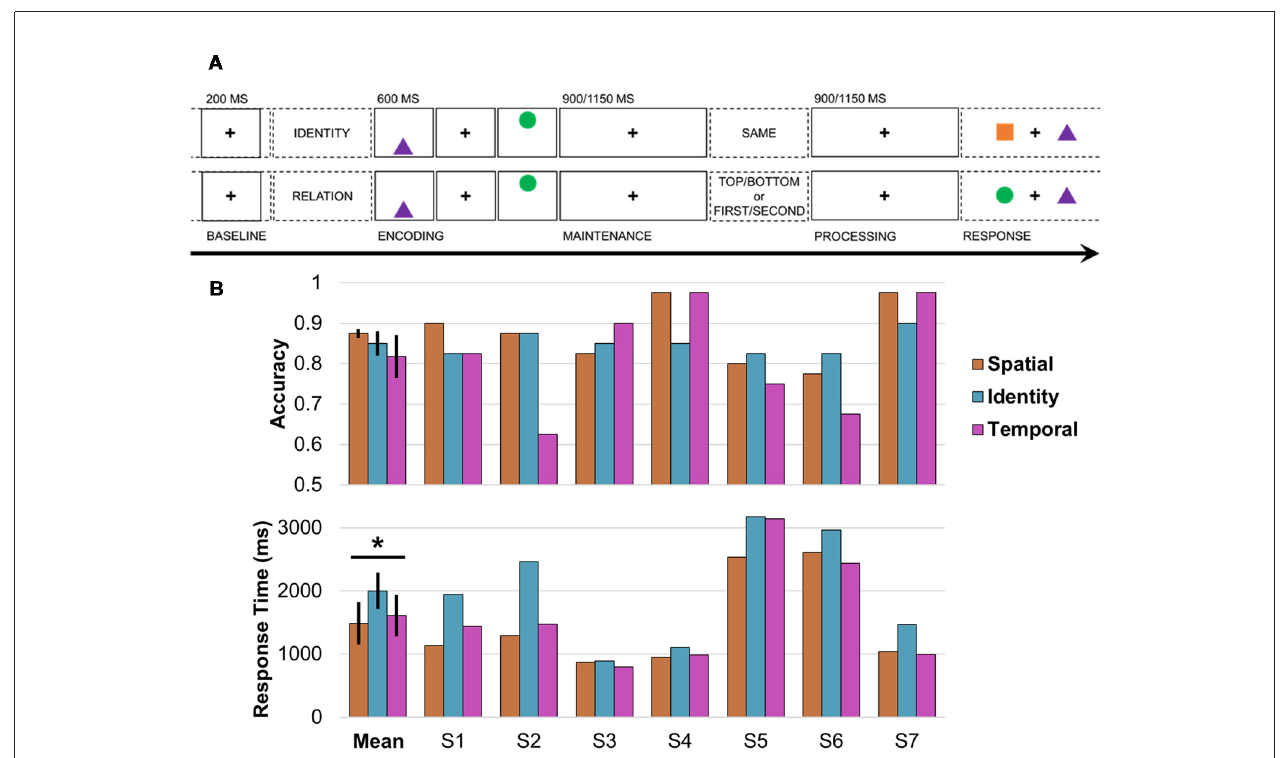
FIGURE 1 | Working memory task design and behavior. (A) Single-trial working memory task design. Following a 1-s pretrial fixation interval ( − 250 to − 50 ms pretrial epoch used as baseline), subjects were directed to focus on either IDENTITY or RELATION information. Then, two common shapes were presented for 200 ms each in a specific spatiotemporal configuration (i.e., top/bottom spatial and first/second temporal positions). After a 900- or 1,150-ms jittered pre-cue fixation delay (“maintenance”), the test cue appeared (i.e., one word presented on screen for 800 ms), followed by a post-cue fixation delay of the same length (“processing”). Working memory was tested in a two-alternative forced choice test (0.5 chance rate). In the identity test (top), subjects indicated whether the pair was the SAME pair they just studied (correct response in this example: no). In the spatiotemporal relation test (bottom), subjects indicated which shape fit the TOP/BOTTOM spatial or FIRST/SECOND temporal relation cue (correct response for cue TOP or SECOND: circle). (B) Mean and per-subject task accuracy (top) and response time (RTs; bottom). ∗ Significant result; error bars, SEM; S, subject; orange, spatial trials; blue, identity trials; pink, temporal